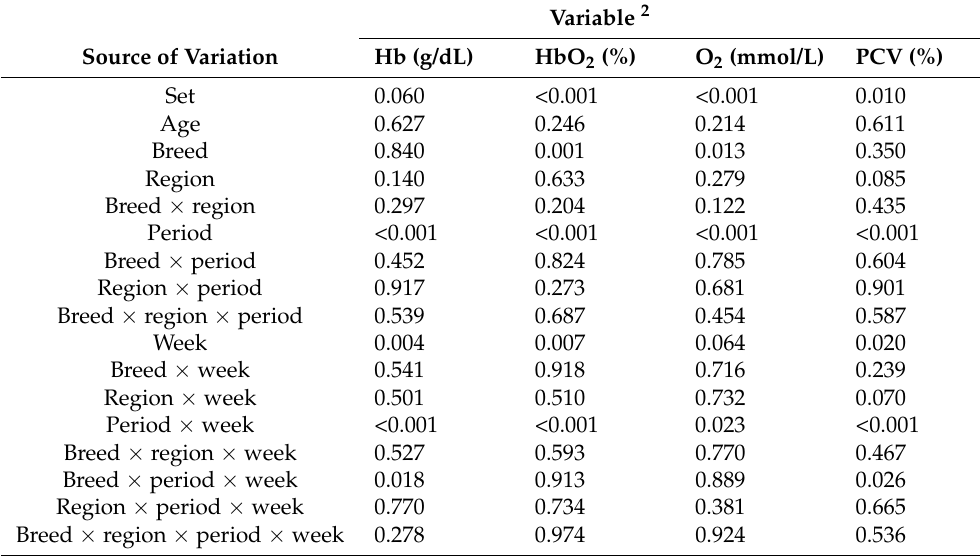
Table 1. p values for effects of region, breed, and period with different heat load indexes, and week within period on hemoglobin concentration and oxygen saturation, blood oxygen concentration, and packed cell volume in hair sheep based on samples collected at the end of each week of the four 2 weeks periods 1